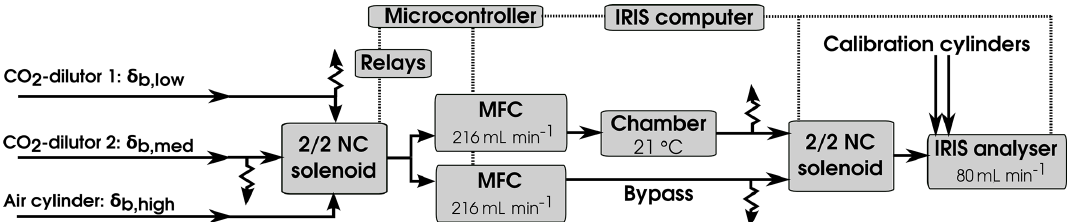
Figure 1. Schematic of the system used to make gas exchange measurements. Alternate measurements of the concentration and δ 18 O of CO 2 in chamber (C a , δ a ) and bypass lines (C b , δ b ) are made under three inlet conditions ( δ b , low , δ b , med , δ b , high ) that differ in terms of the δ 18 O of CO 2